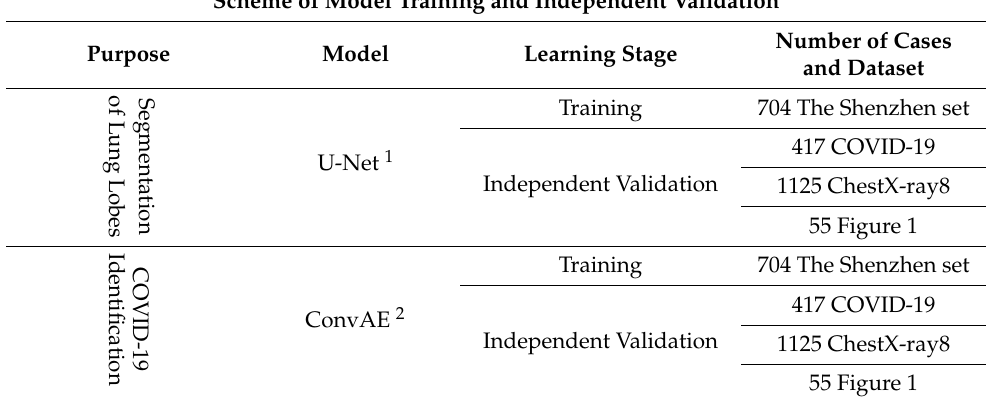
Table 1. Training and validation scheme for the proposed